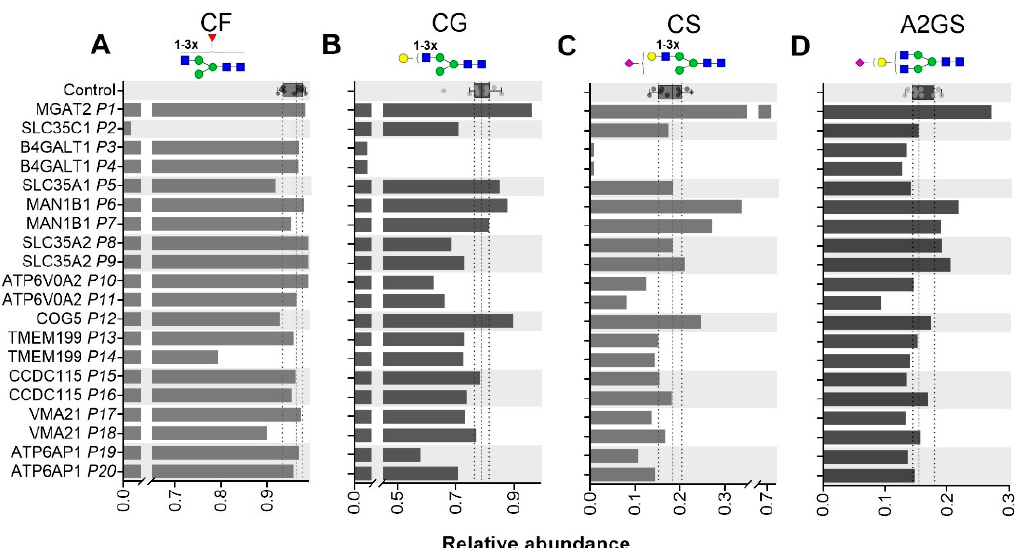
Figure 5. IgG1 Fc glycosylation of CDG patients. Levels of IgG1 Fc fucosylation ( A ), galactosylation ( B ) sialylation ( C ) and sialylation per galactose ( D ) as determined at the glycopeptide level are displayed for 20 CDG patients. Reference values as determined for healthy controls ( n = 10) are shown by box plot with median (dashed line) and interquartile range (dotted lines).